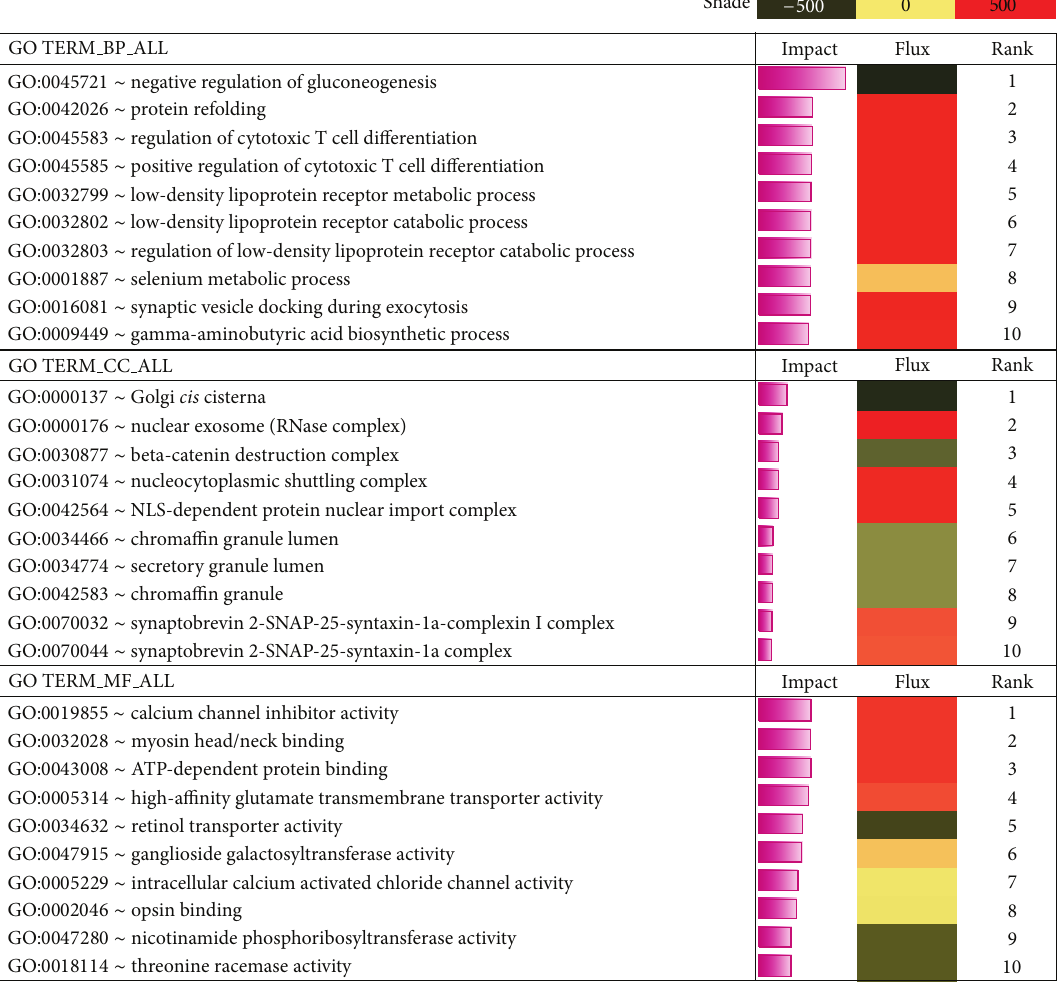
Figure 3: Top ten affected GO terms (DAVID) by trans -10, cis -12-CLA in mammary tissue. The horizontal bars denote the impact of DEG on the GO terms. The larger the horizontal bar, the greater the impact. The direction of the impact is indicated under flux, green = inhibition and red = activation. The intensity of the color indicates the extent of inhibition (if green) or activation (if red); that is, darker the color, the greater the effect on the GO terms. BP: biological processes; CC: cellular components; MF: molecular